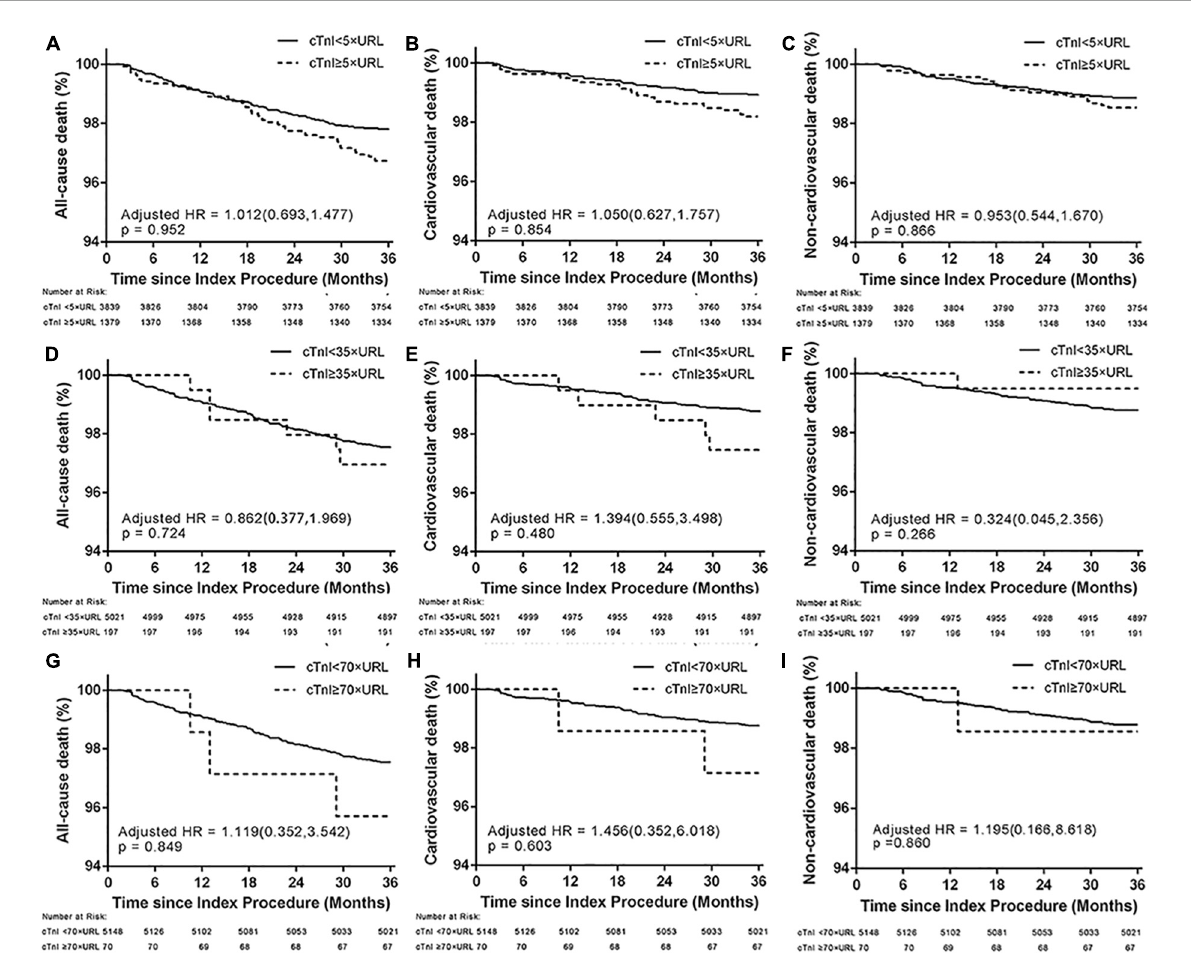
FIGURE4 Three-year Kaplan–Meier curves for all-cause death (A,D,G) , cardiovascular (B,E,H) , and non-cardiovascular death (C,F,I) in patients who underwent PCI with different post-PCI peak cTnI values according to the biomarker criterion of the 4th UDMI, ARC-2, and SCAI definitions. ARC-2, Academic Research Consortium-2; SCAI, Society for Cardiovascular Angiography and Interventions; UDMI, Universal definition of myocardial infarction; URL, upper reference limit.